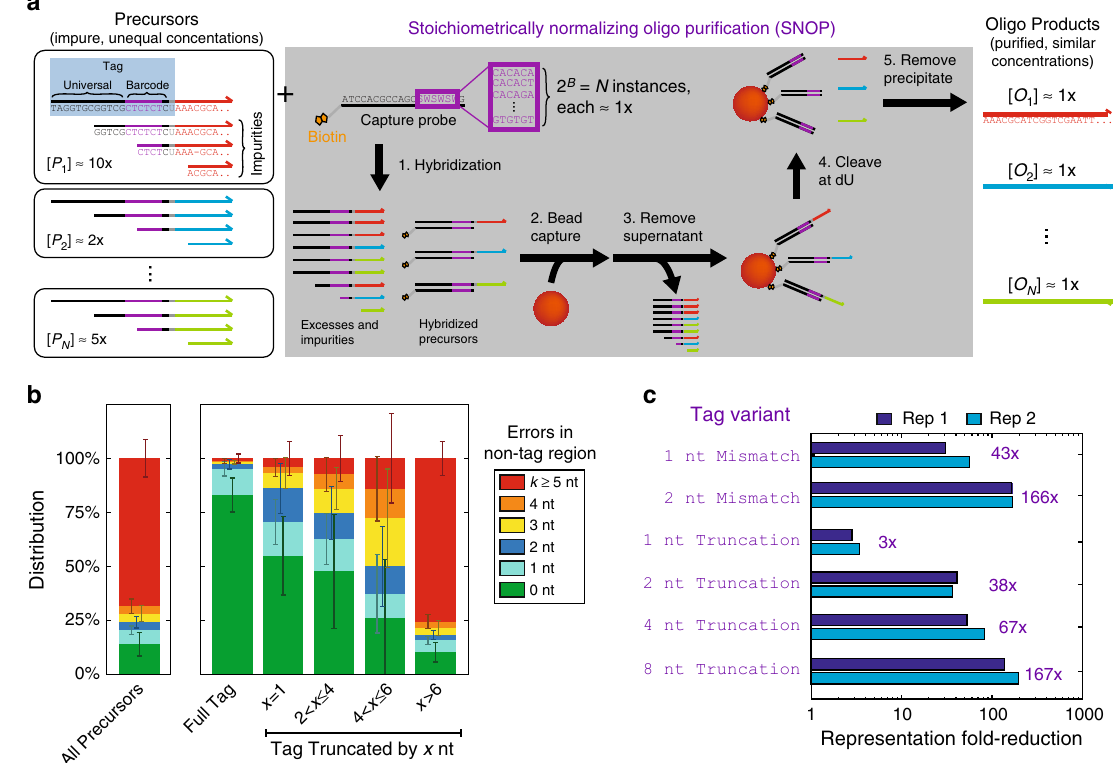
Fig. 1 Stoichiometrically normalizing oligonucleotide puri fi cation (SNOP) concept and work fl ow. a The input reagents for SNOP are chemically synthesized oligonucleotide precursors P 1 through P N that contain imperfect synthesis products with 5 ′ truncations and/or internal deletions, and with potentially very different concentrations. SNOP produces a pool of oligonucleotide products O 1 through O N that has high fractions of oligos with perfect sequence, and